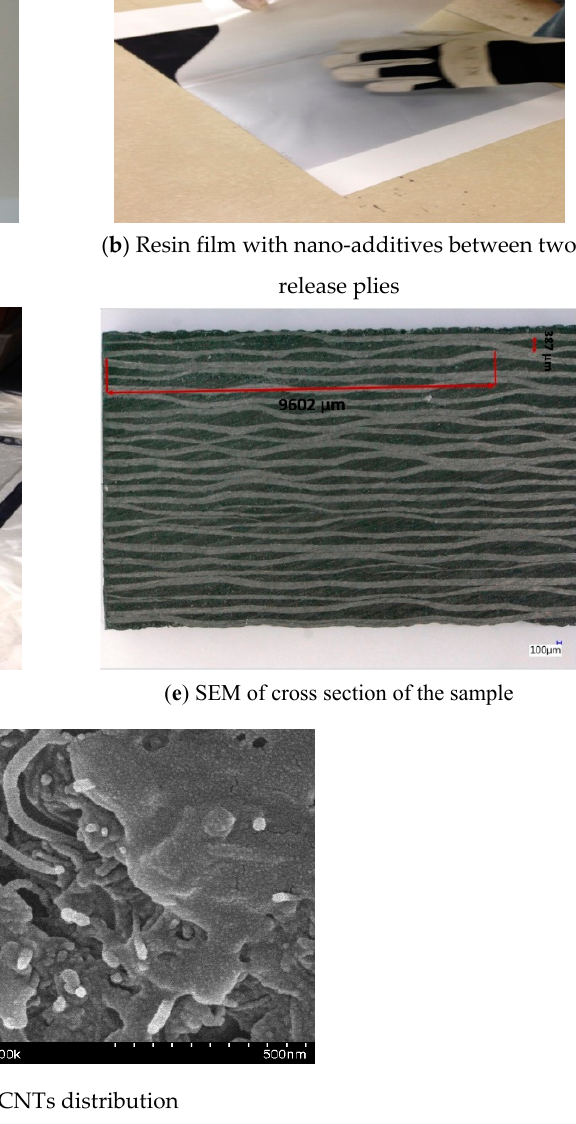
Figure 3. Manufacturing steps.